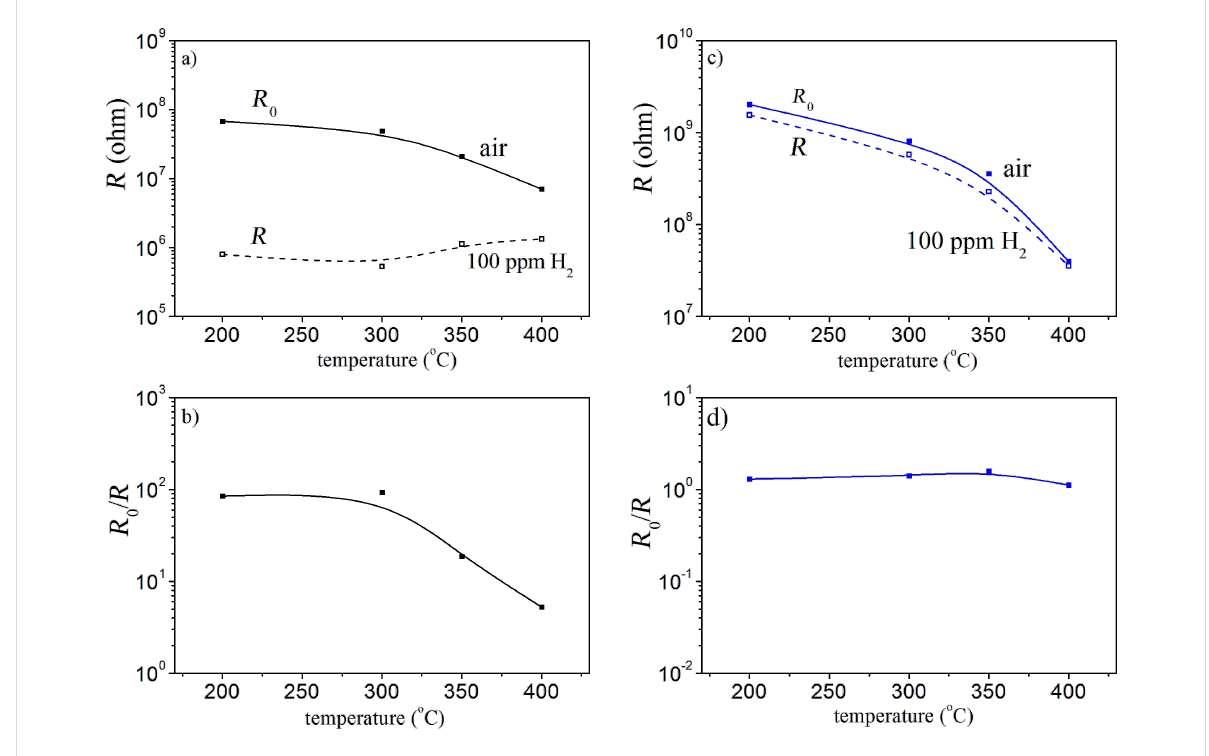
Figure 7: Temperature dependence of the electrical resistance in air, R 0 , compared with that upon interaction with 100 ppm H 2 , R , together with the sensor response, R 0 / R , for the samples of 90 mol % SnO 2 /10 mol % TiO 2 (a, b) and 90 mol % TiO 2 /10 mol % SnO 2 (c, d).